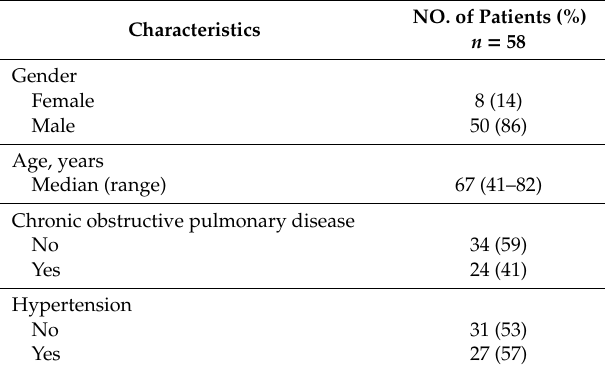
Table 1. Patient